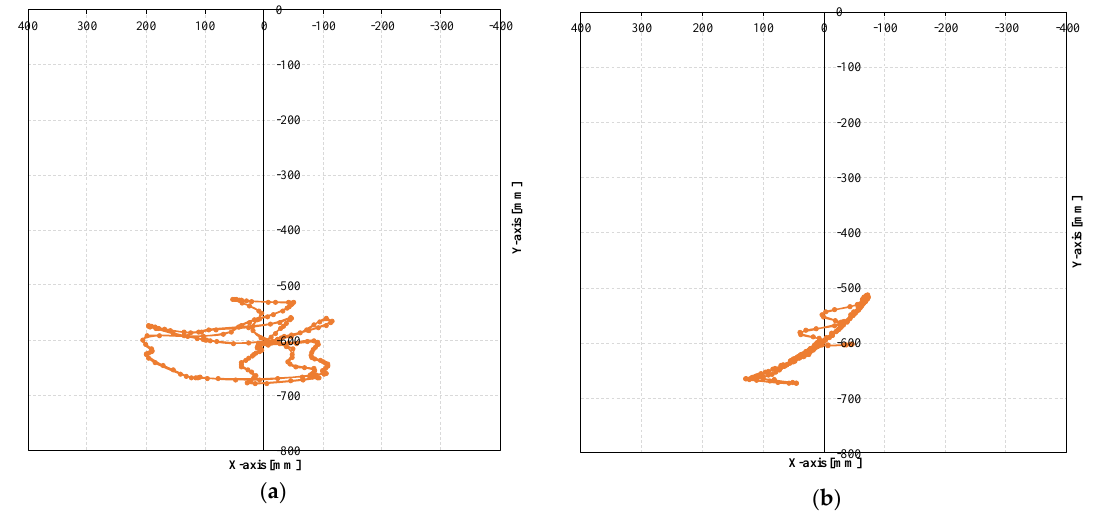
Figure 12. Trajectory of the leg tip using evaluation function 3 without load (( a ) first generation, ( b ) 18th generation).